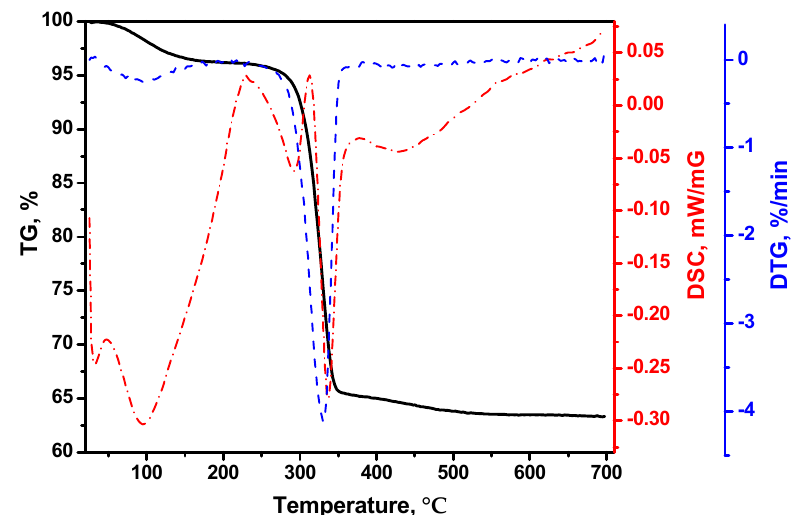
Figure 1. TG, DTG, and DSC profiles of the Cu-Mg-OH xerogel sample. The xerogel Cu-Mg-OH samples and the samples calcined at 500 ◦ C (Cu-Mg-O, oxide) were examined by scanning electron microscopy. The obtained SEM images are shown in Figure 2. Both the samples are represented by poorly crystallized layered agglomerates consisting of nanosized primary particles. At the same time, the xerogel sample (Figure 2a,b) looks fluffy and lacy, while the oxide system (Figure 2c,d) seems to be more dense and compacted. It is natural to suppose that the initial xerogel with a developed structure undergoes collapsing under the calcination conditions.